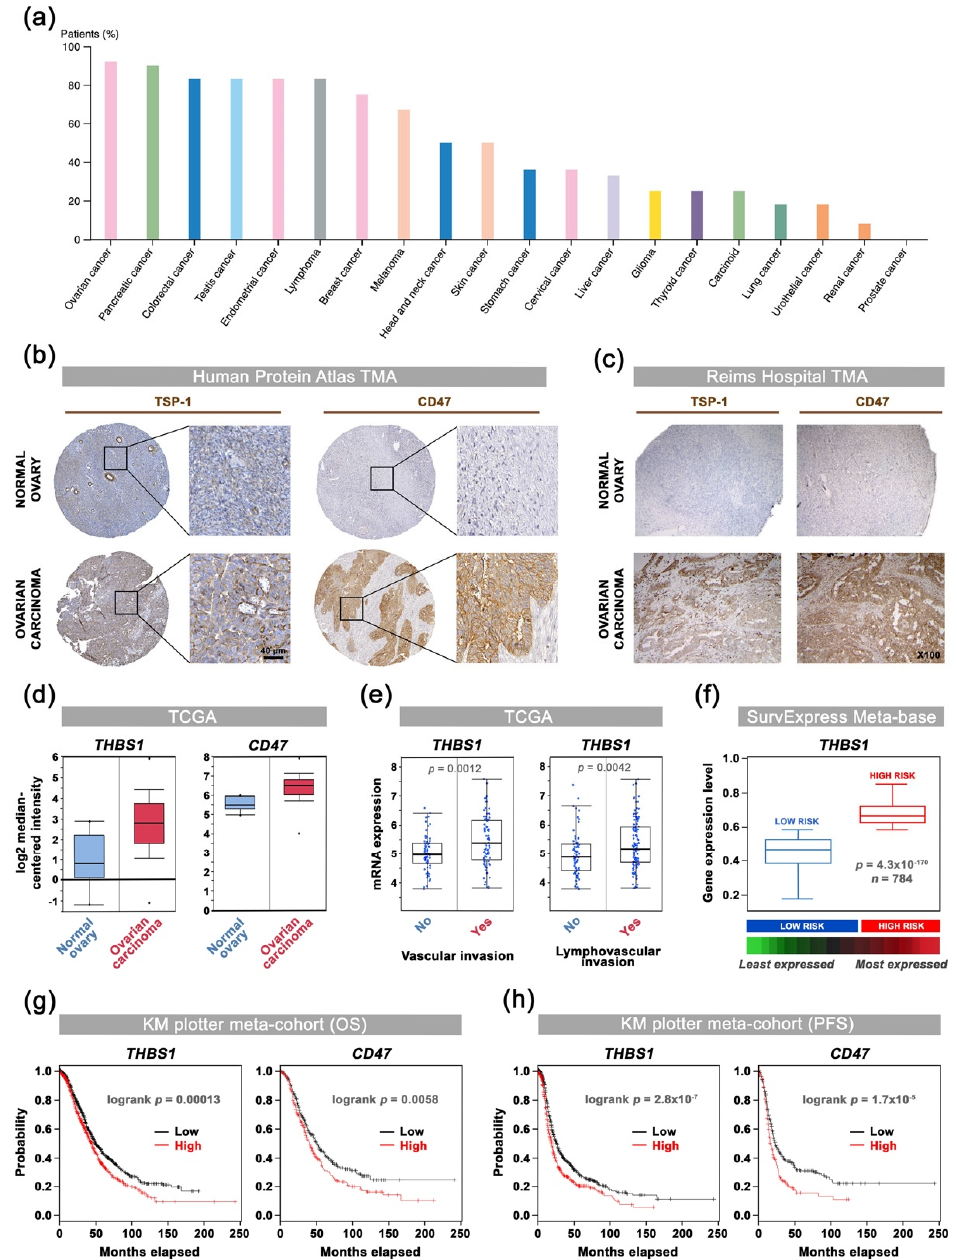
Figure 2. Correlation of TSP-1 and CD47 expression with patient outcome in ovarian carcinoma: a comprehensive review of clinical data. ( a ) Analysis of TSP-1 protein expression among 20 cancer types. The histogram displays the percentage of patients being positive for TSP-1 by IHC (validated antibody: CAB033678) for each cancer type, as retrieved among cohorts from the Human Protein Atlas (available from www.proteinatlas.org; accessed on 11 January 2018). ( b , c ) Microphoto- graphs of TSP-1 and CD47 IHC in normal ovary and ovarian carcinoma tissue microarrays from ( b ) the Human Protein Atlas dataset, as well as from ( c ) a Reims Hospital cohort. ( d ) Results for THBS1 (probe: 201110_s_at) and CD47 (213857_s_at) differential gene expression analysis (log2, median-centered; Affymetrix U133 signal) among TCGA dataset, as retrieved by using the Oncomine TM platform. Boxes show the median and interquartile range, while bottom and top bars of the whisker indicate the 10 th and 90 th percentiles, respectively. Min/max values are also indicated (bullet) and more